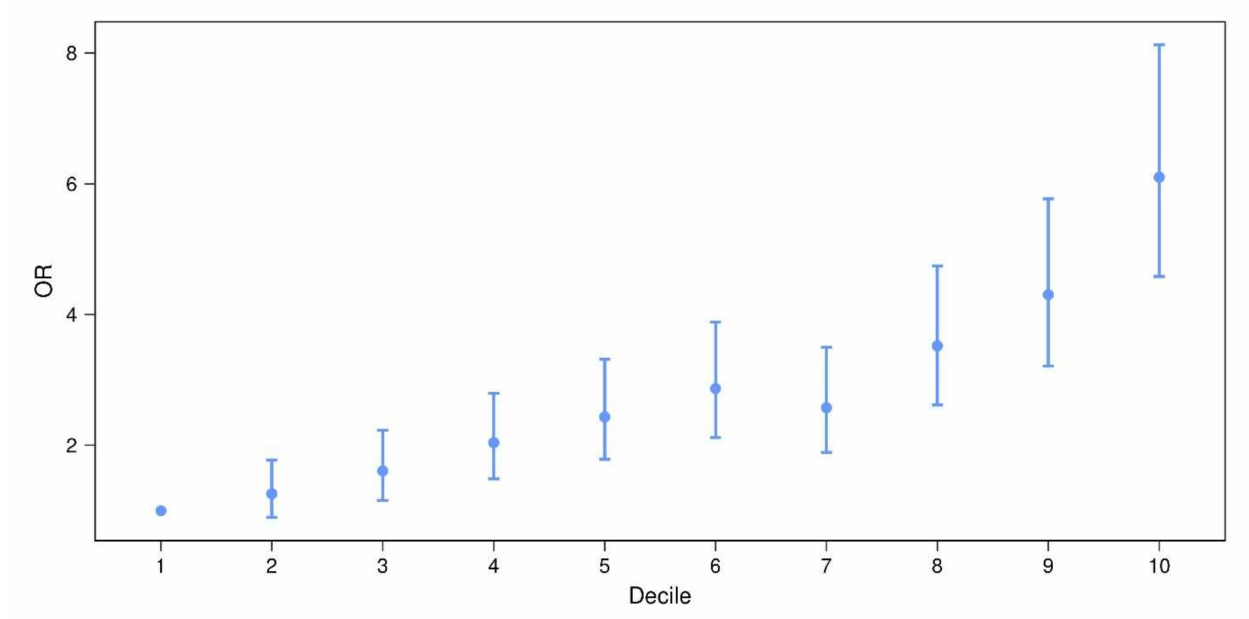
Figure 2. Disease OR for the 2nd to 10th deciles of the PD-PRS distribution among controls. (1st decile used as reference). Vertical bars demarcate 95% confidence intervals. OR: odds ratio, PD: Parkinson’s disease, PRS: polygenic risk score.